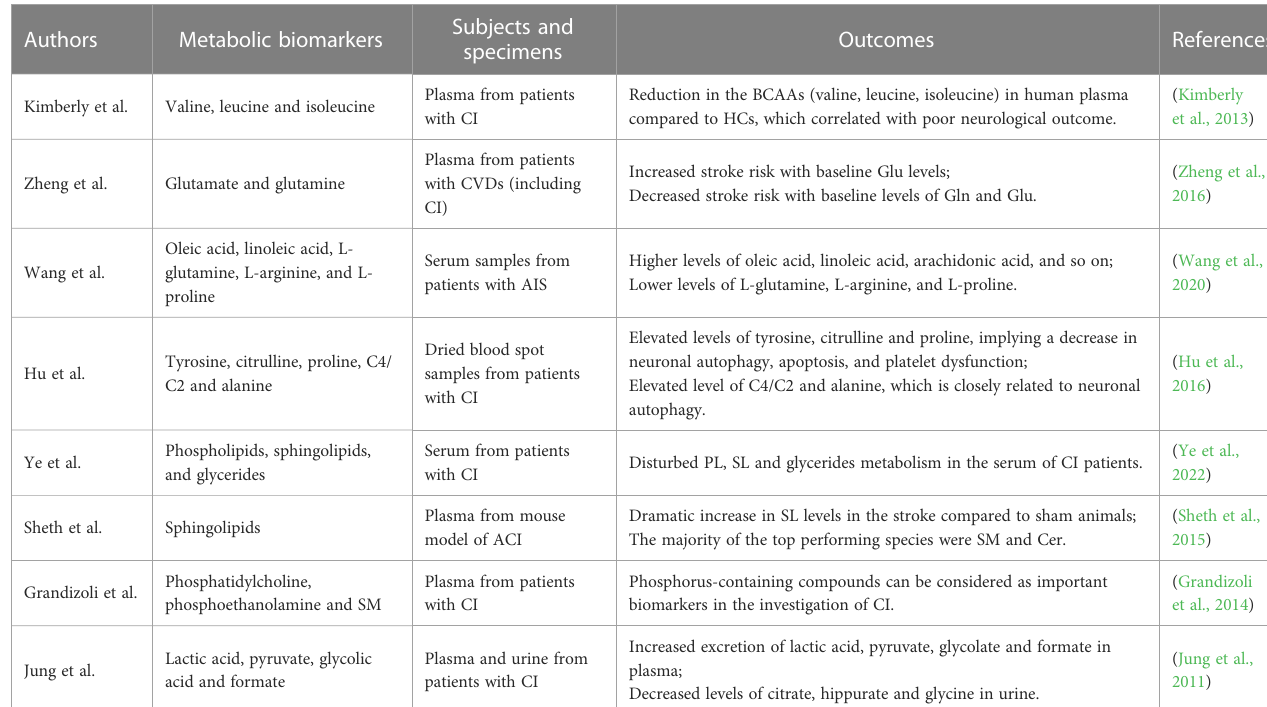
TABLE 2 Metabolic biomarkers in cerebral